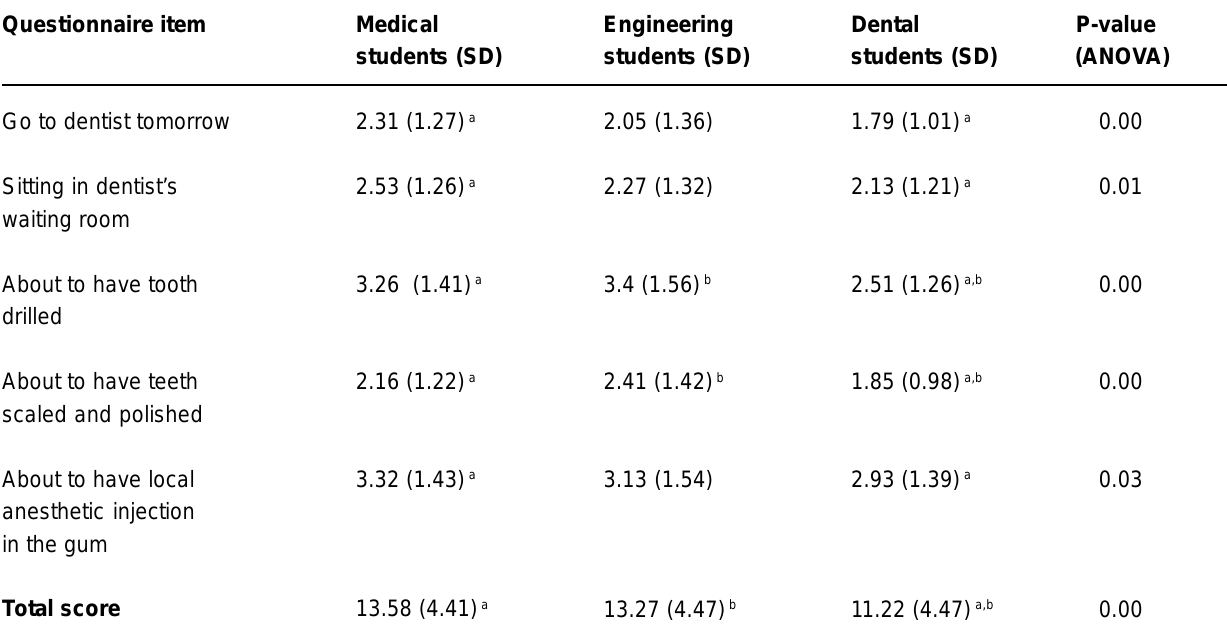
SD = Standard Deviation. * Values with same letters in each row are statistically different.